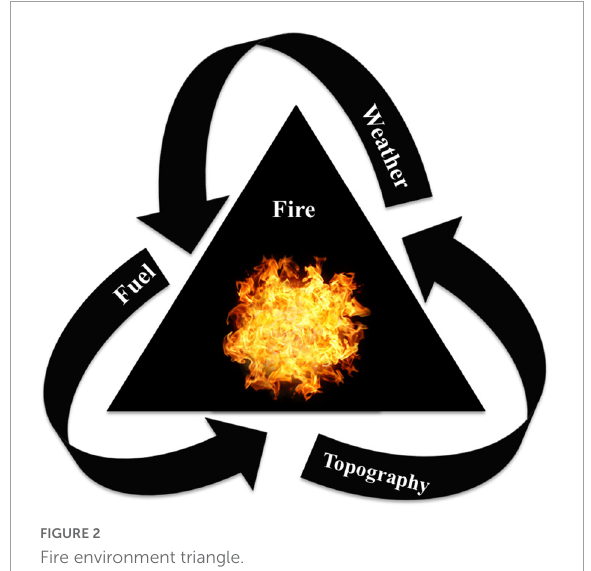
FIGURE2 Fire environment